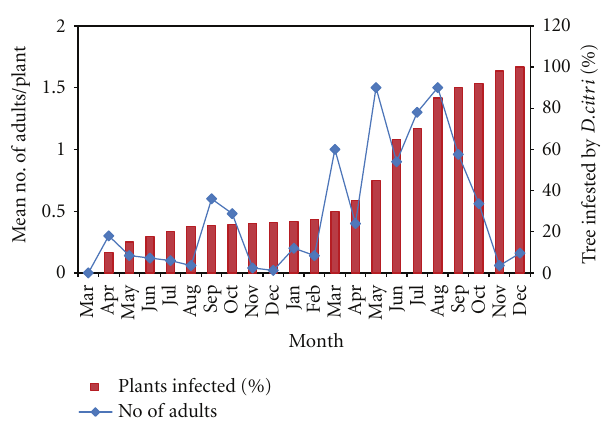
Figure 1: Incidence and spread of D. citri population in a citrus orchard at